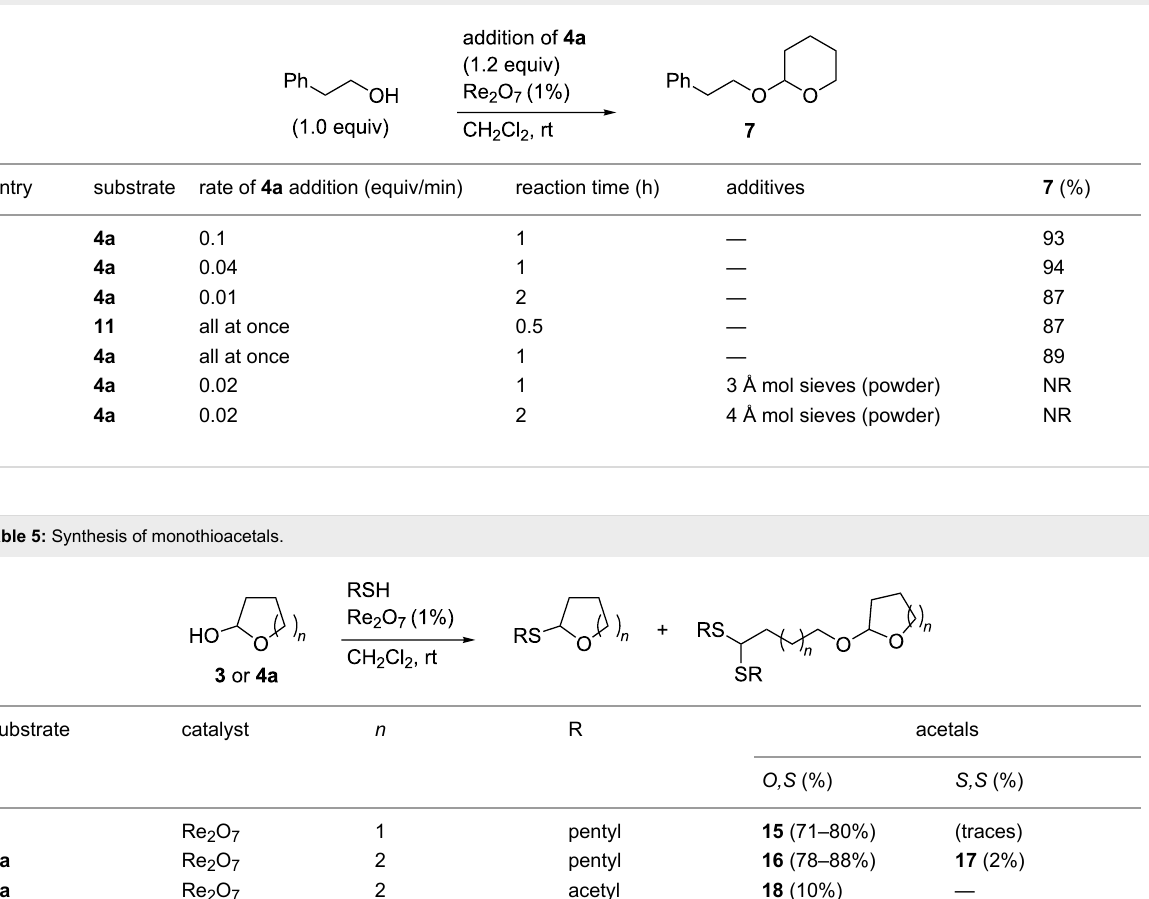
Table 4: Optimization of acetalization conditions.